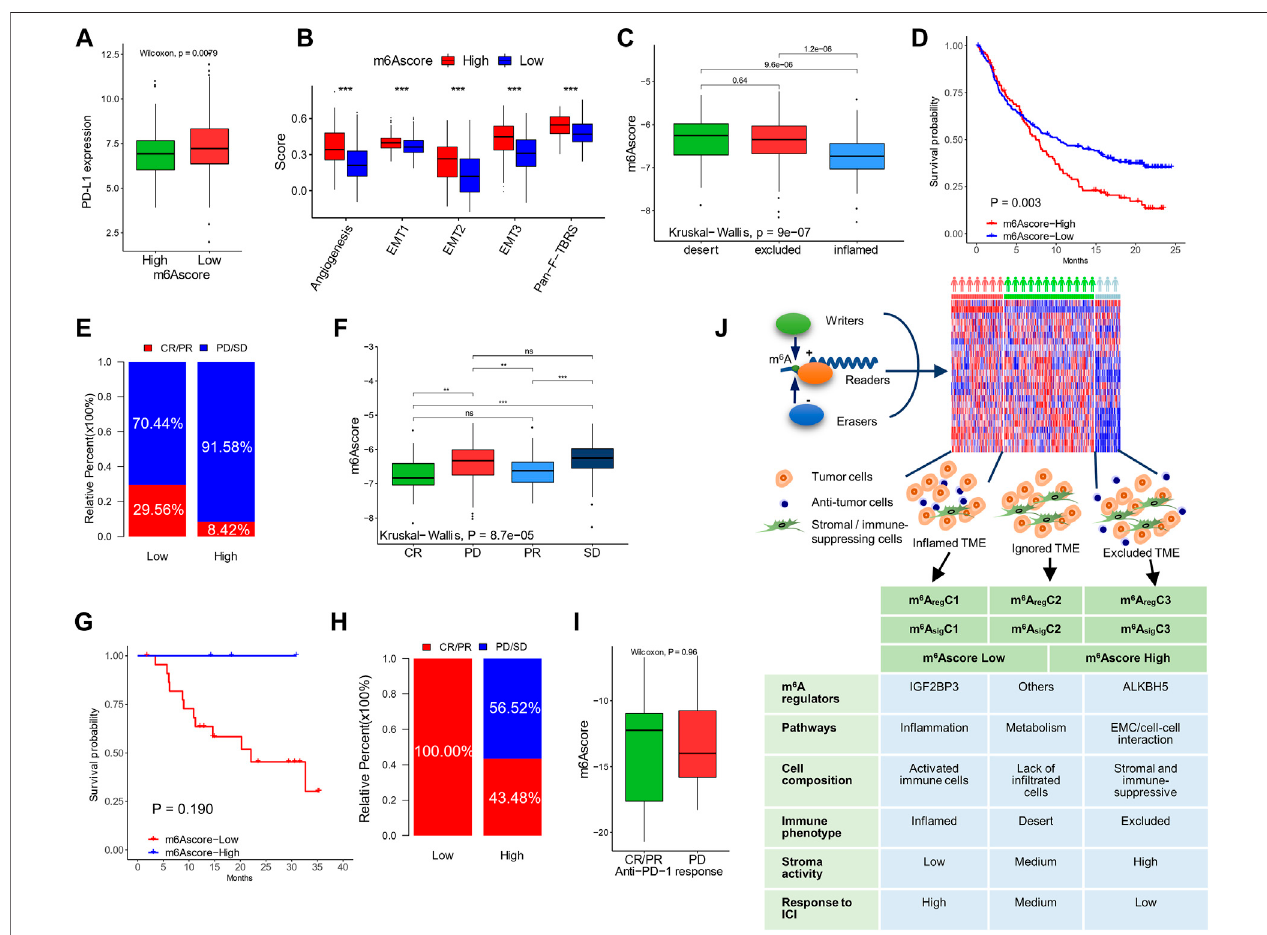
FIGURE8| Theabilityofm 6 AscoretopredictresponsestoICI. (A) PD-L1expressioninpatientswithhighandlowm 6 AscoresintheIMvigor210cohort. (B) Stromal activationsignaturesinpatientswithhighandlowm 6 Ascores. (C) m 6 Ascoresintheignored,excluded,andin fl amedtypesoftumors. (D,E) Kaplan – Meiercurves (D) and response rates (E) in patients with high and low m 6 Ascores after treatment of ICI. (F) m 6 Ascores in patients with different responses to ICI. Data of (A – F) were from the IMvigor210 cohort. (G,H) Kaplan – Meier curves (G) and response rates (H) to ICI in patients with high and low m 6 Ascores after treatment of ICI in the GSE78220 cohort. (I) m 6 Ascores in patients with different responses to ICI in the GSE78220 cohort. (J) Graphic abstract of this study (top) and characteristics of the subtypes (bottom). * p < 0.05; ** p < 0.01; *** p < 0.001.